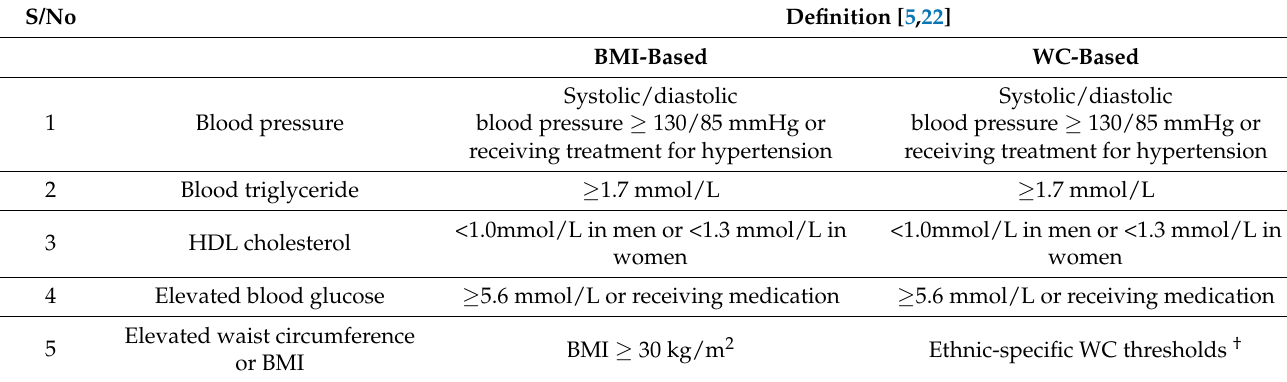
Table 1. Criteria for defining the MHO